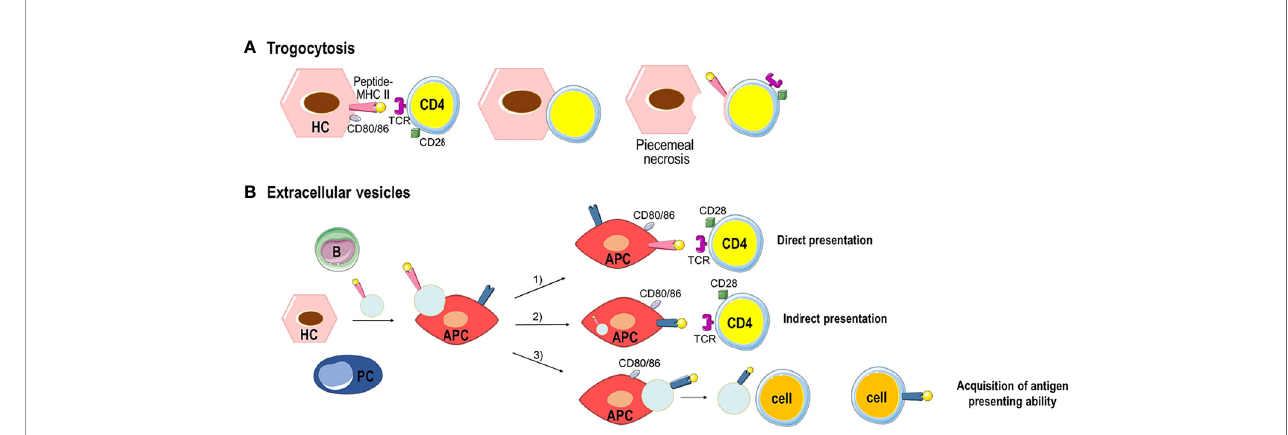
FIGURE 3 | Examples of peptide-MHC complex transfer by trogocytosis or extracellular vesicles. (A) Trogocytosis between MHC class II-expressing HCs and CD4 + T cells resulting in the transfer of the membrane fragment with the peptide-MHC class II complex to CD4 + T cells. HCs that lose part of their membrane go to death (piecemeal necrosis). (B) All parenchymal and nonparenchymal cells produces extracellular vesicles. Extracellular vesicles bearing peptide-MHC class II complexes are taken up by APC triggering three separate immune responses: 1) direct presentation of antigen and priming of CD4 + T cells. 2) the peptide-MHC class II complex is processed by the APC, and the antigen peptide is bound to the MHC class II molecules of APC to elicit indirect antigen presentation and CD4 + T cell priming. 3) after the processing the antigen peptide is bound to the MHC class II molecules of APC and the new peptide-MHC class II complex is transferred through extracellular vesicles to other cells which acquire antigen presenting